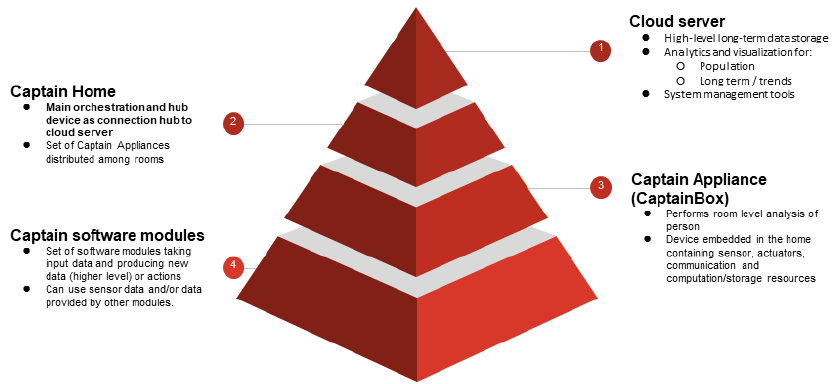
Figure 3. Physical view of CAPTAIN coaching platform.